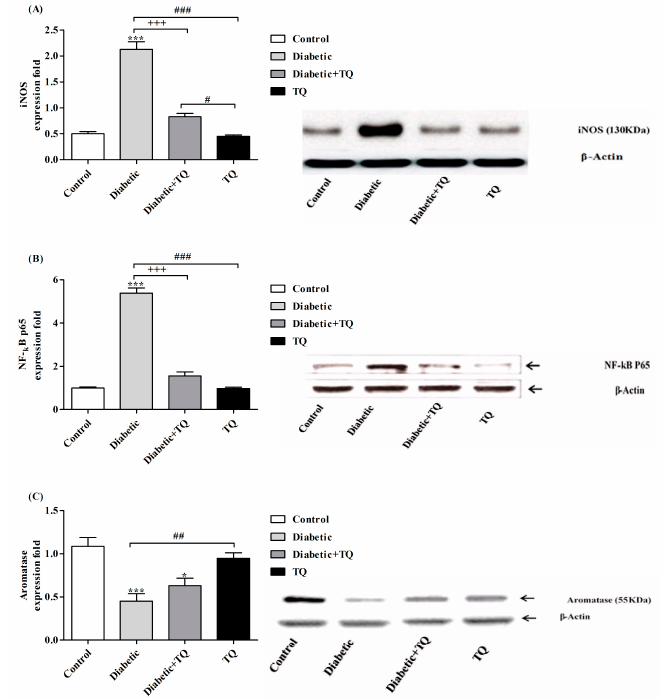
Figure 6. Western blotting analysis of iNOS ( A ), NF- κ B-p65 ( B ), and Aromatase ( C ) in Control, Diabetic, Diabetic + TQ, and TQ groups. * p < 0.05 and *** p < 0.001 vs. Control. +++ p < 0.001 vs. Diabetic. # p < 0.05, ## p < 0.01 and ### p < 0.001 vs. TQ. TQ; thymoquinone.